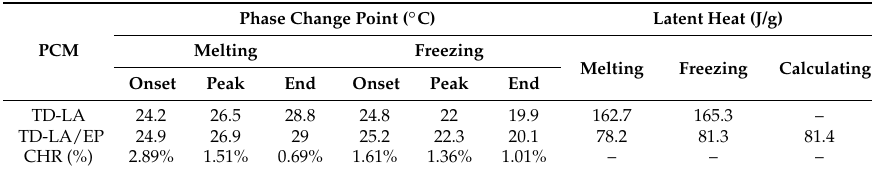
Table 4. Thermal properties for the TD-LA and TD-LA/EP.